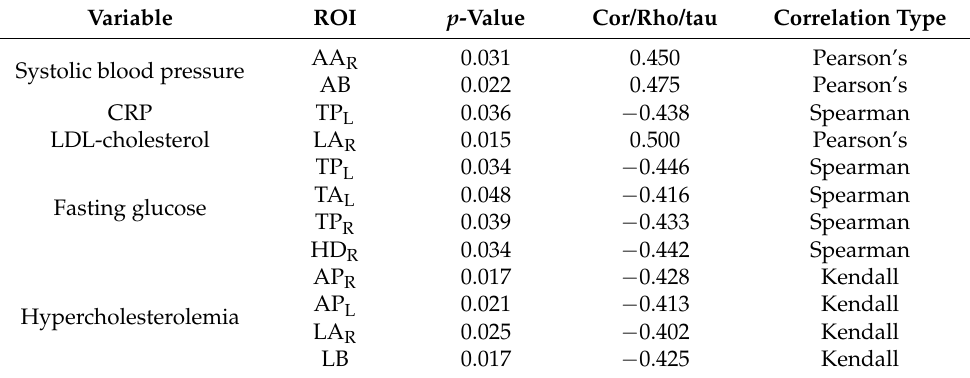
ROI—region of interest; Cor—Pearson’s correlation coefficient; Rho—Spearman’s correlation coefficient; tau— Kendall’s correlation coefficient; CRP—C-reactive protein; LDL—low-density-lipoprotein cholesterol; AA R —arm anterior right; AB—abdomen; TP L —thigh posterior left; LA R —leg anterior right; TP L —thigh anterior left; TA L — thigh anterior left; TP R —thigh posterior right; HD R —hand dorsal right; AP R —arm posterior right; AP L —arm posterior left; LB—lower